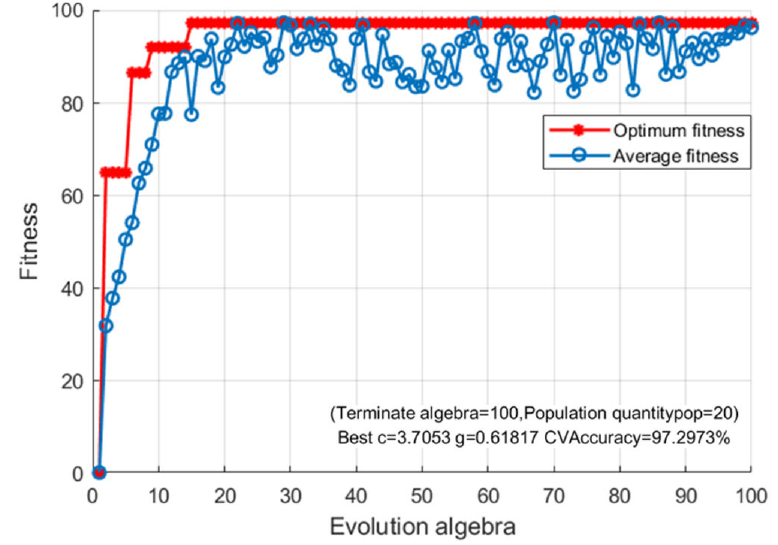
Figure 4. Genetic algorithm iteration graph.